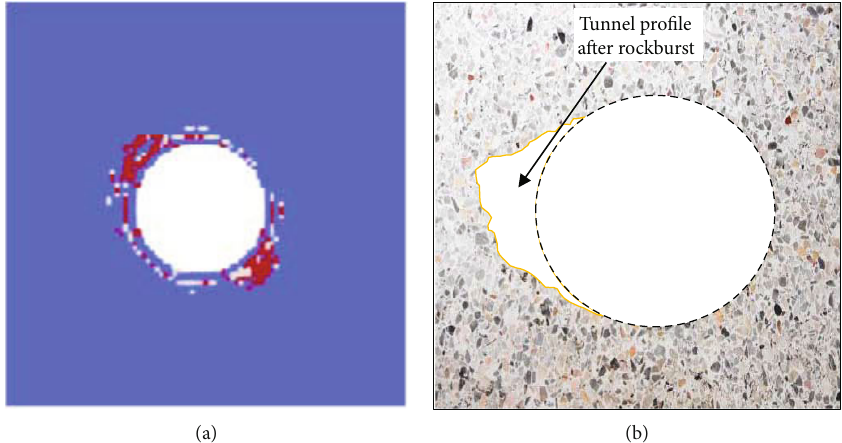
Figure 14: Comparisons between the IKSPH results and the engineering practice. (a) IKSPH results. (b) Engineering practice